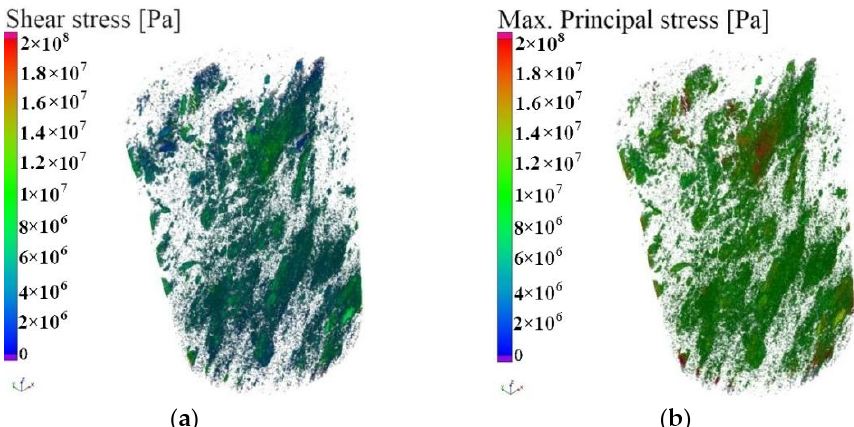
Figure 16. Simulated 3D displacement field under different loads.